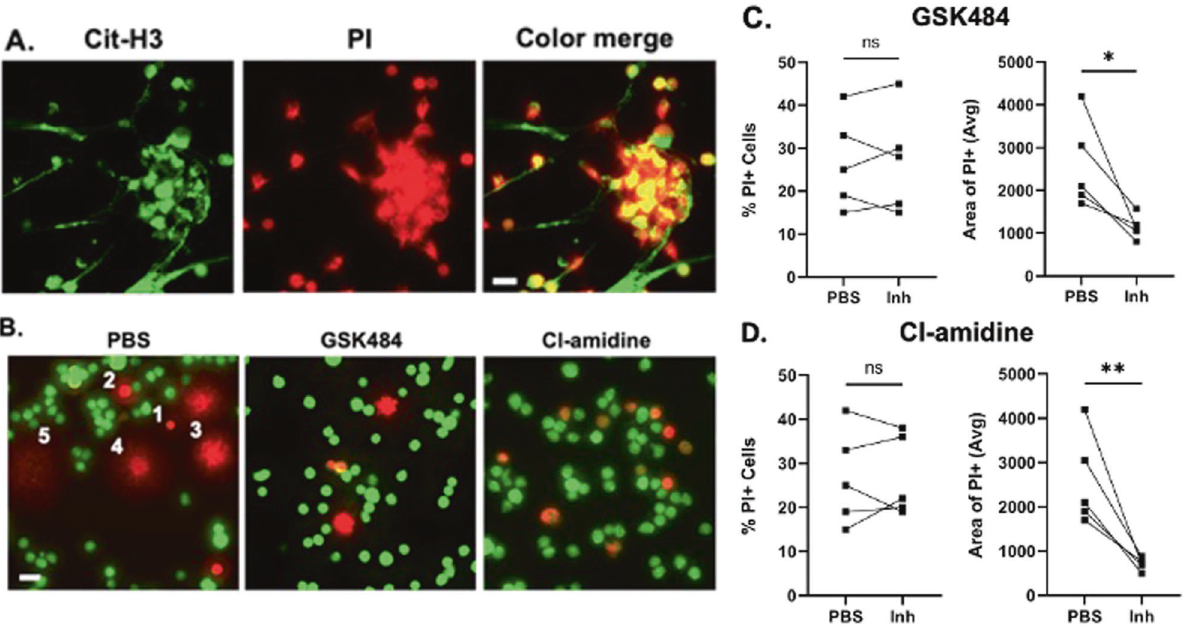
Fig. 2 NETosis-like death of tonsillar B cells. A Immuno fl uorescence of tonsillar B cells stained for hyper-Cit-H3 and DNA. Tonsillar IgM + IgD + CD27- B cells stained with anti-hyper-Cit-H3 (green) and PI (red) after 2 h at 37 °C. Scale bar = 10 µm. Data are representative of 4 subjects. B Inhibition of chromatin decondensation by PAD inhibitors. Tonsil IgM + IgD + CD27- B cells treated with PAD inhibitors, GSK484 or Cl-amidine. Cells labeled with Calcein AM (green); dead cells labeled with PI (red). Photos are representative of 5 subjects. Numbers 1 – 5 represent putative chromatin decondensation steps ((1) compact nucleus; (2) and (3) swollen nucleus; (4) swollen nucleus with fi ne DNA branches; (5) fi ne strands of DNA). C , D Quanti fi cation of cell death (PI + ) and chromatin decondensation (average area of PI + cells (square pixel)) in untreated and GSK484- ( C ) or Cl-amidine- ( D ) treated cells; paired t -test, * P -value < 0.05, ** P -value <